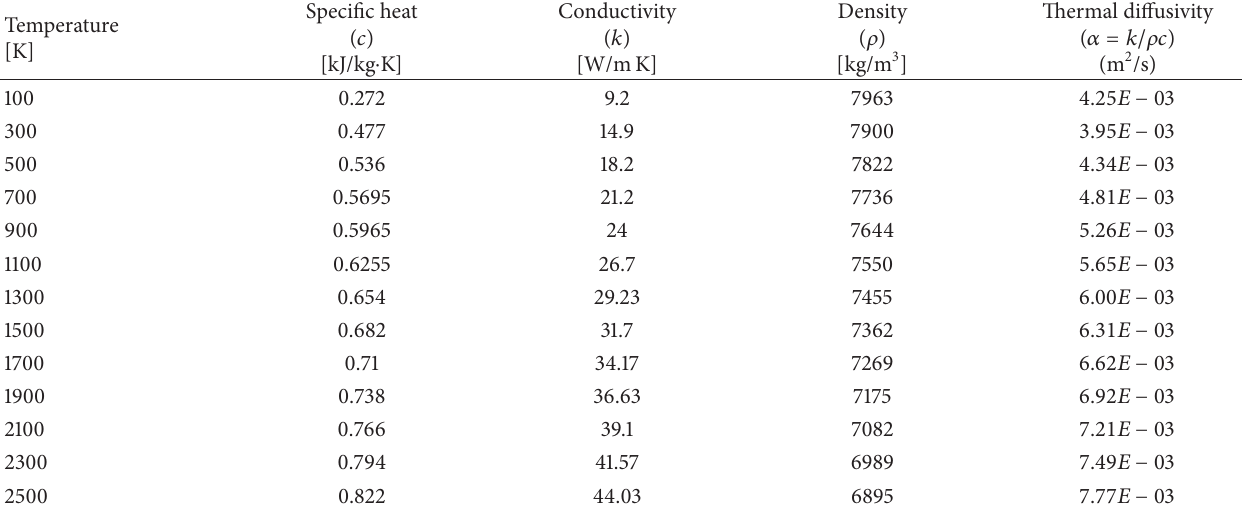
Table 1: Thermal properties of AISI 304 stainless